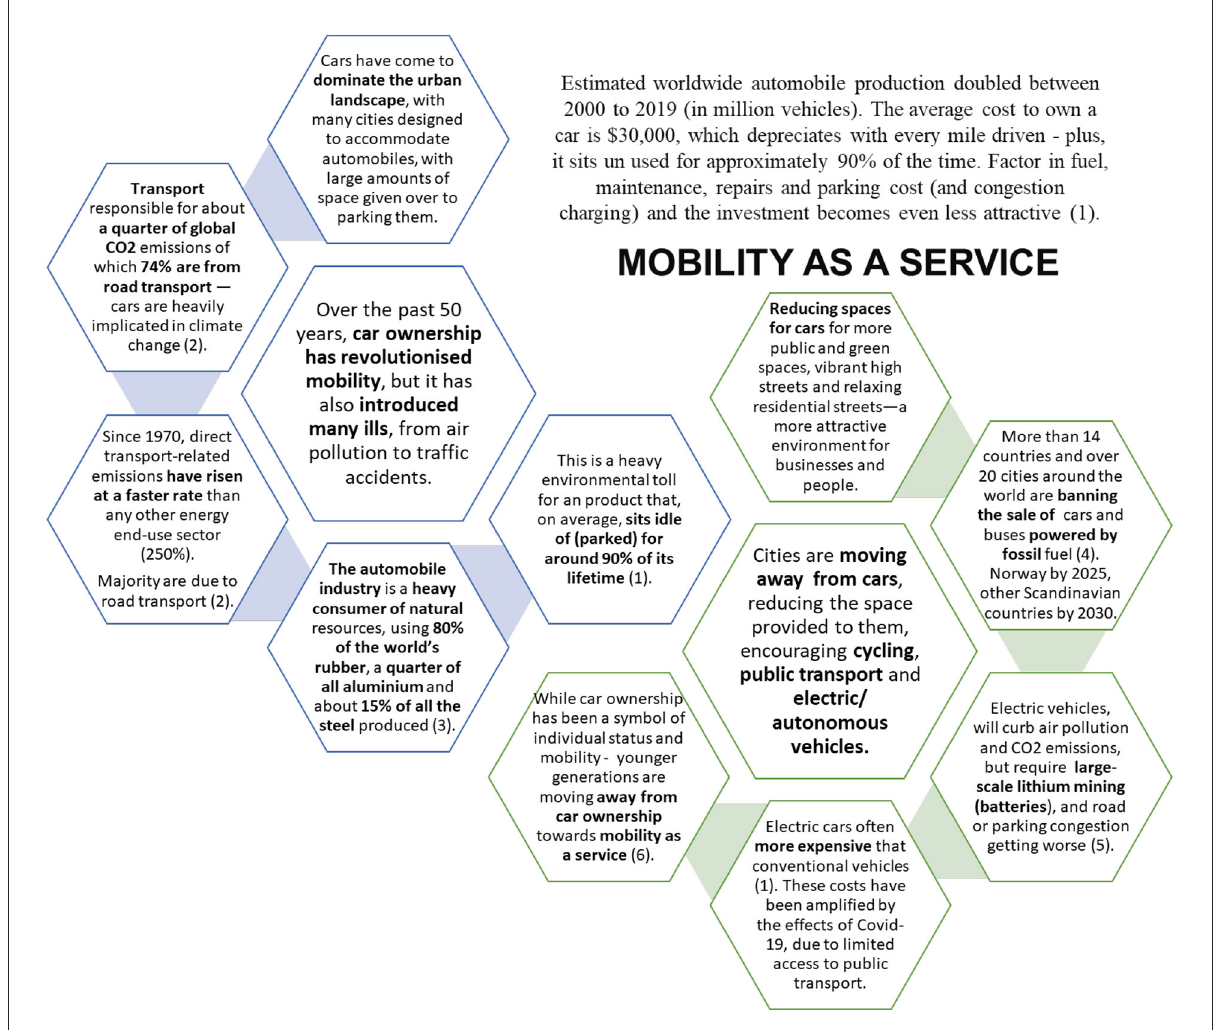
FIGURE5 The case for Mobility in urban centers as a Service (1) IEA, 2019; (2) Sims et al., 2014; (3) Norman et al., 2021; (4) IEA, 2021; (5) Sanguesa et al., 2021; (6) Moody et al.,